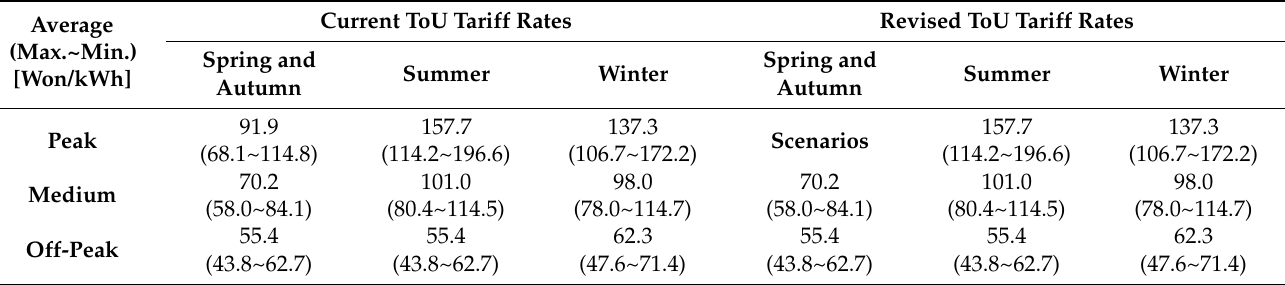
Table 10. Comparison between current ToU tariff and revised ToU tariff rates.